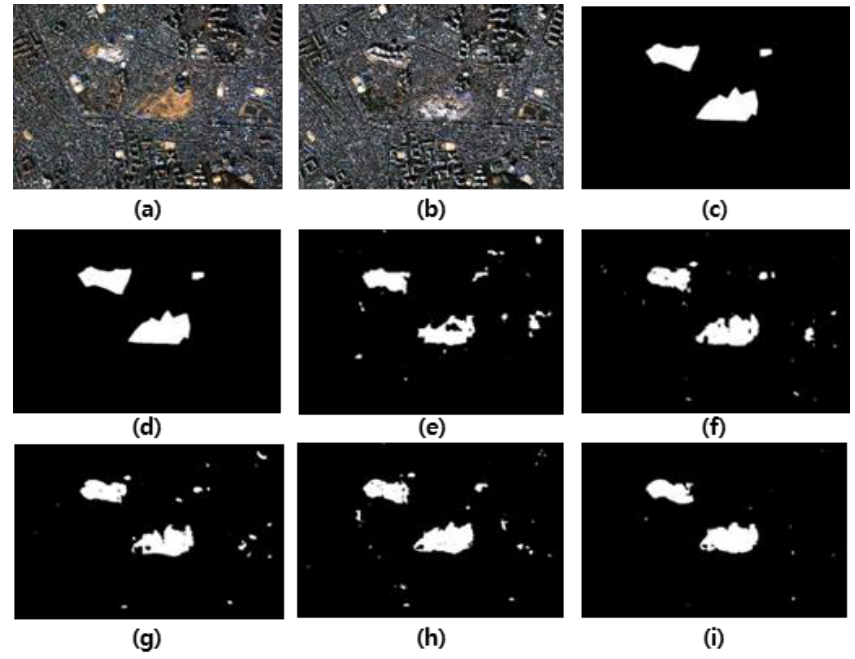
Figure 12. Changed detection maps of the proposed and conventional algorithms for “Test area 1”: ( a ) Image P; ( b ) Image C; ( c ) Ground truth; ( d ) DI + UNet; ( e ) DI + ATTUNet; ( f ) JF + UNet; ( g ) JF + ATTUNet; ( h ) Modified-UNet++; ( i ) Proposed bilateral dissimilarity U-Net.